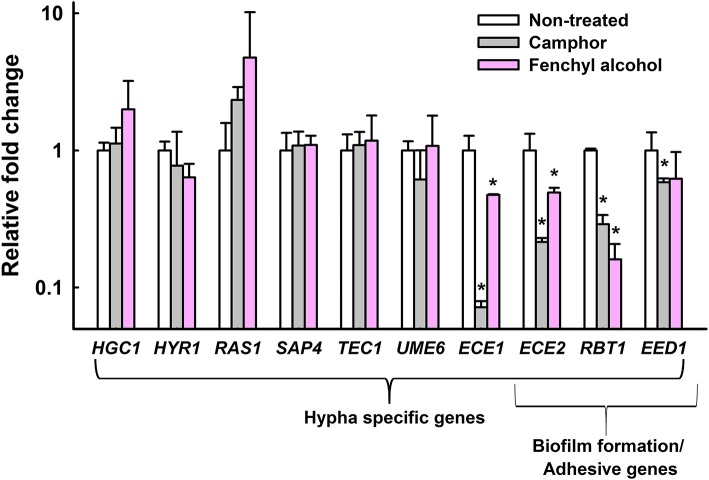
Transcriptional profiles of C. albicans cells treated with or without camphor or fenchyl alcohol. C. albicans was cultivated with or without camphor (0.01%) or fenchyl alcohol (0.01%) for 4 h. Transcriptional profiles were measured by qRT-PCR. Relative expressions represent transcriptional levels after treatment with camphor or fenchyl alcohol as compared to non-treated controls. Fold changes represents transcription changes in treated C. albicans vs. non-treated controls (value of 1.0). The experiment was performed in duplicate. Error bars indicate standard deviations. *p < 0.05 vs. non-treated controls.